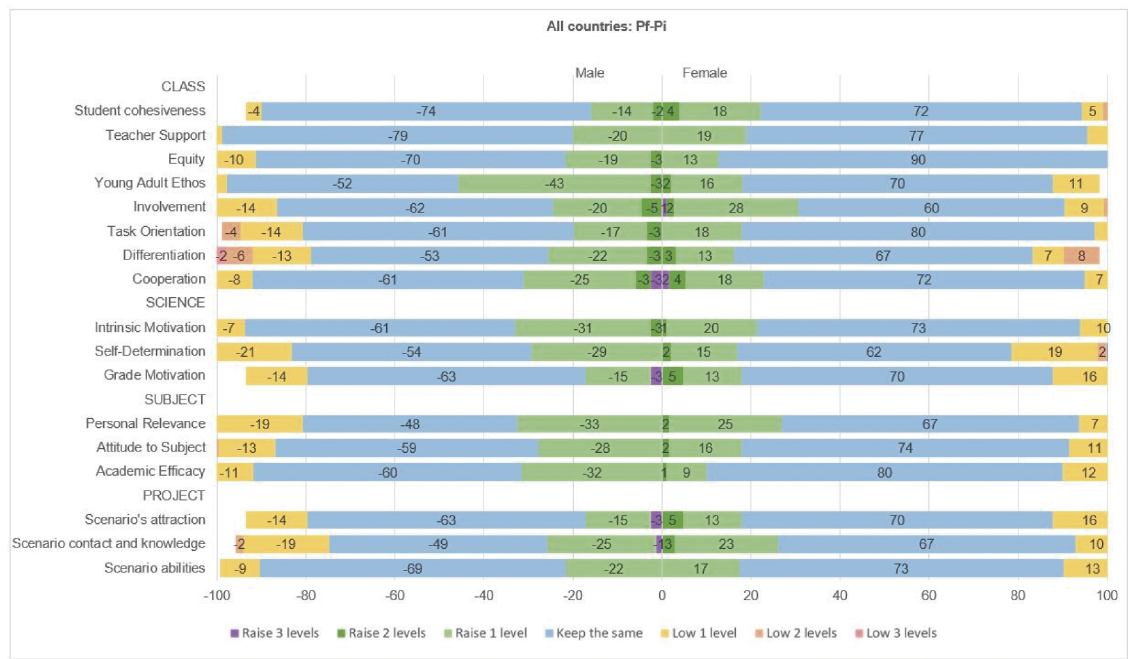
Figure 7. Difference between the desired situation at the end of the project in a hypothetical projection